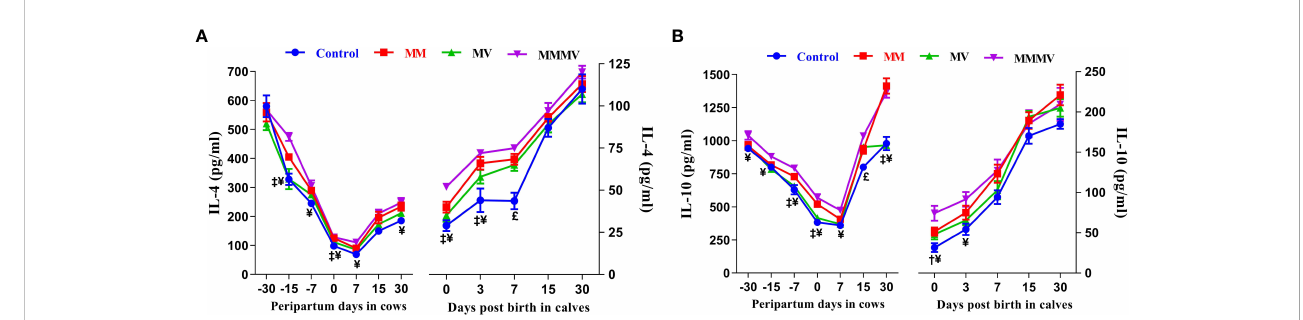
FIGURE 9 The blood plasma concentration of anti-in fl ammatory cytokines (pg/ml) including IL-4 (A) , and IL-10 (B) in control and treatment groups of crossbred cattle and their calves. Control: received basal diet only, MM: basal diet + injectable multimineral, MV: basal diet + injectable multivitamins, MMMV: basal diet + combination of injectable multimineral and multivitamins. The mean values with different superscript symbols represent signi fi cant differences with the control group at different days of peripartum in cows and post birth in calves; ‡ Control Vs MM, † Control Vs MV, ¥ Control Vs MMMV. £ Control Vs MM, MV and